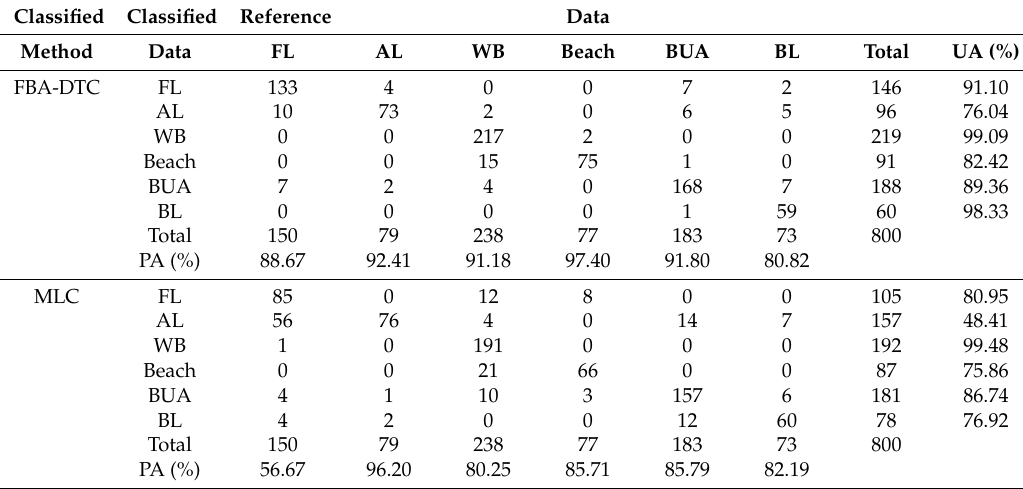
Table 5. Accuracy assessment of feature-based approach of decision tree classification (FBA-DTC) and maximum likelihood classification for the 2003 image.